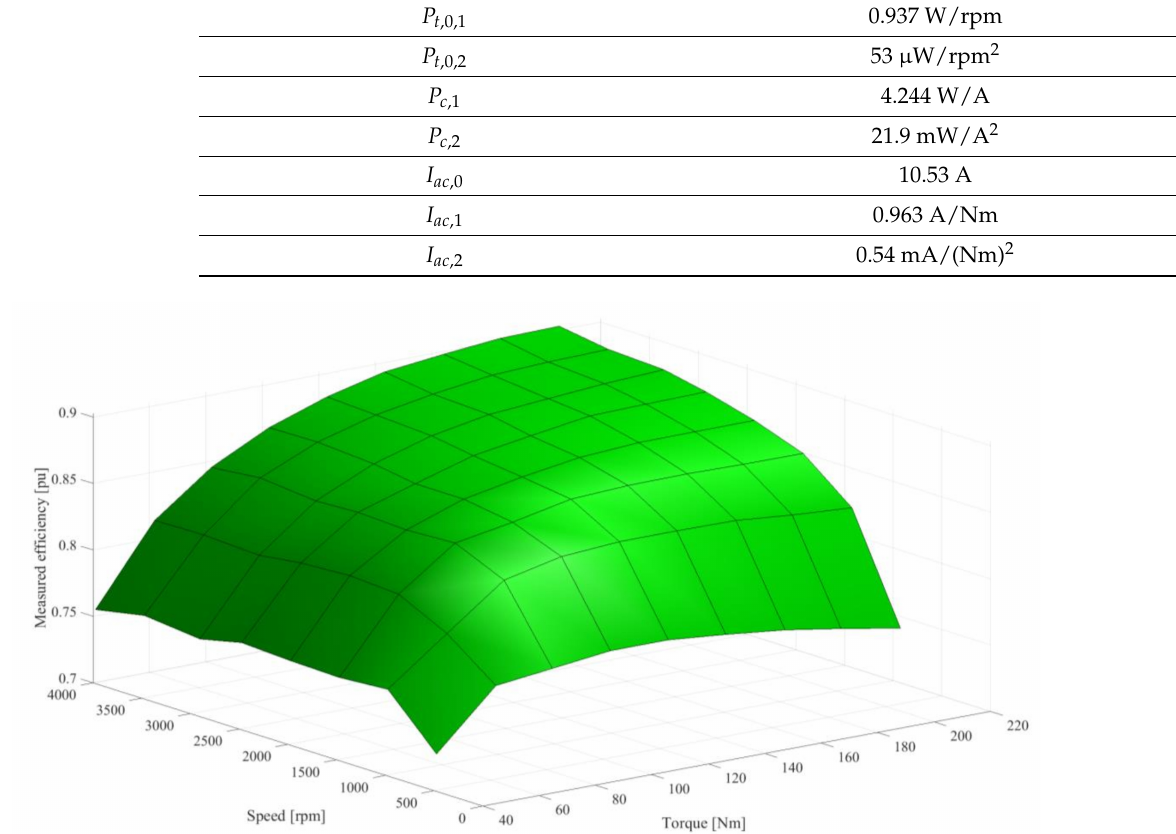
Figure 1. Interpolated surface of the measured system efficiency based on experimental data as a function of torque and speed.